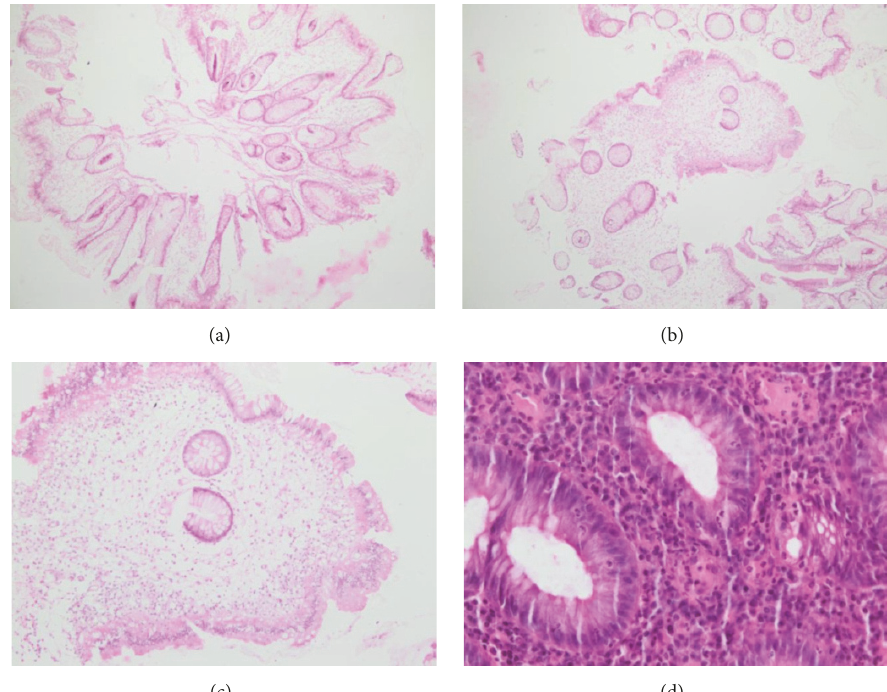
Figure 2: (a) Polypoid structure formed by disorganized and rarefied glands and crypts in an inflammatory and edematous lamina propria. (b)-(c) Inflammatory lamina propria and rarefied glands. (d) Cryptitis: exocytosis of polynuclear neutrophils in the glands.